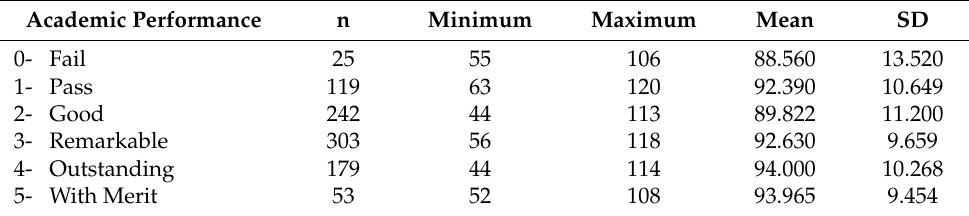
Table 2. The ASAS scores and components according to academic